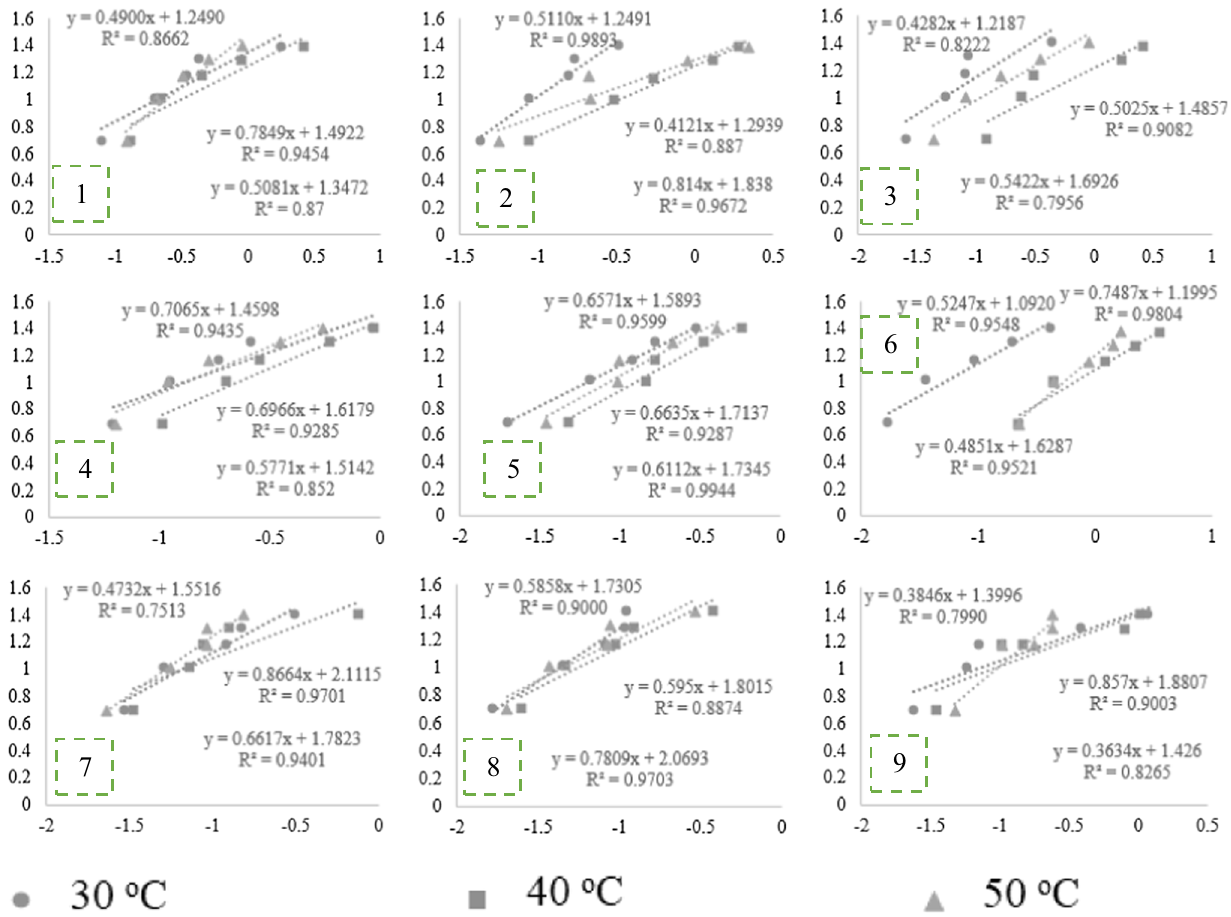
Fig. 6 Linear regression analysis of Freundlich isotherm for samples C1-700 (1), C2-700 (2), C3-700 (3), C1-750 (4), C2-750 (5), C3-750 (6), C1-800 (7), C2-800 (8), and C3-800 (9) at 30 ℃ , 40 ℃ , and 50